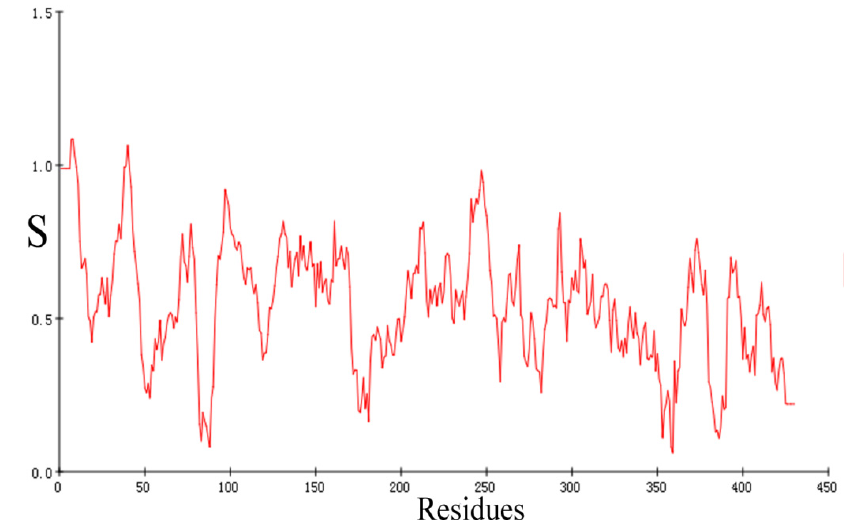
Figure 4. Verify-3D score of